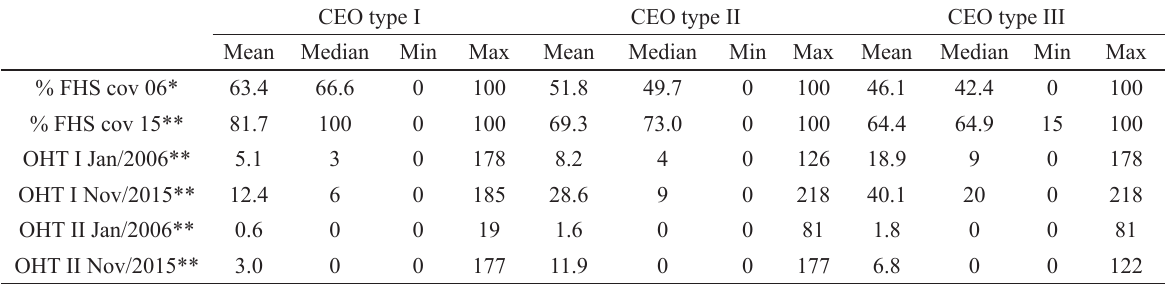
Comparision of the three types of CEO in the variables of coverage rate and number of teams (Kruskal-Wallis non- parametric test,